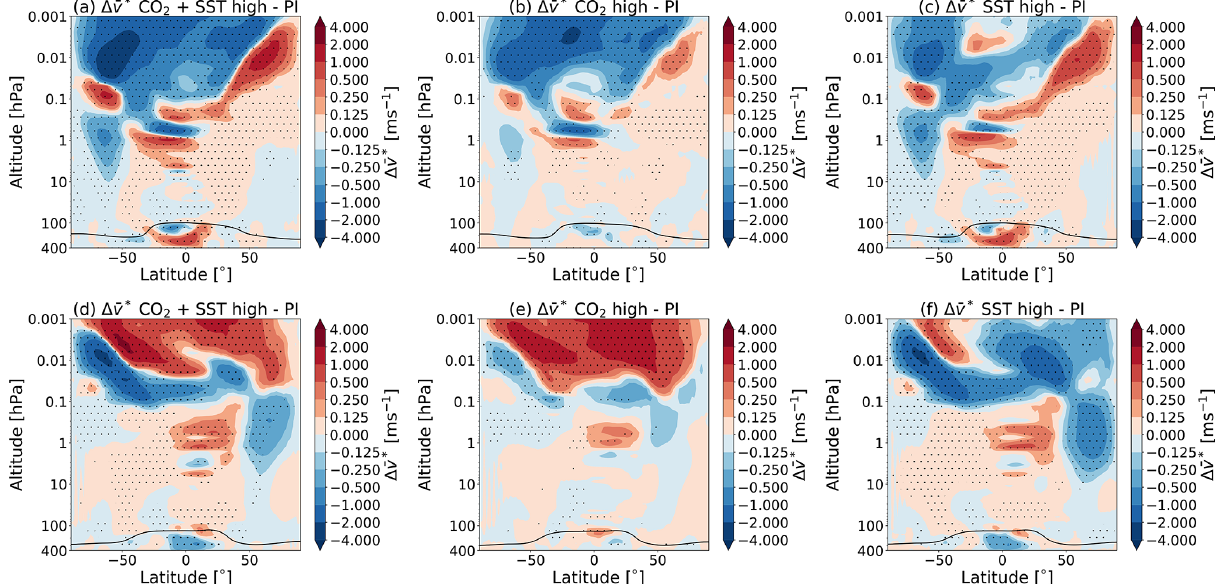
Figure 6. Changes in the zonal and monthly mean transformed Eulerian mean residual circulation horizontal velocity ¯ v ∗ for July (a–c) and January (d–f) due to (a, d) the combined effect of the CO 2 increase and SST changes (experiment S3–C1), (b, e) the doubling of the atmospheric CO 2 concentration (experiment S1–C1) and the (c, f) SSTs (experiment S2–C1) as simulated by WACCM. The dotted regions indicate the regions where the data reach a confidence level of 95%. The tropopause height is as indicated in Fig.